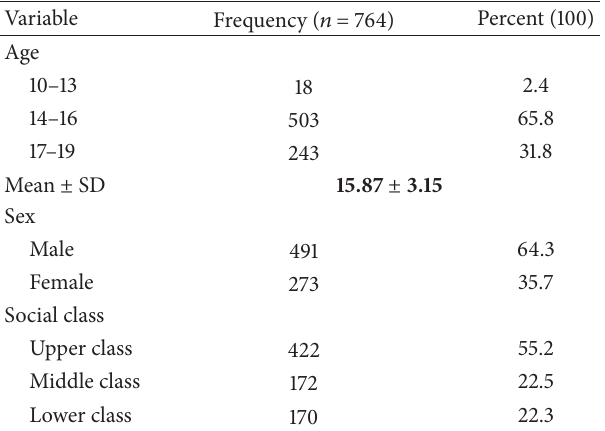
Table 1: Sociodemographic characteristics of the